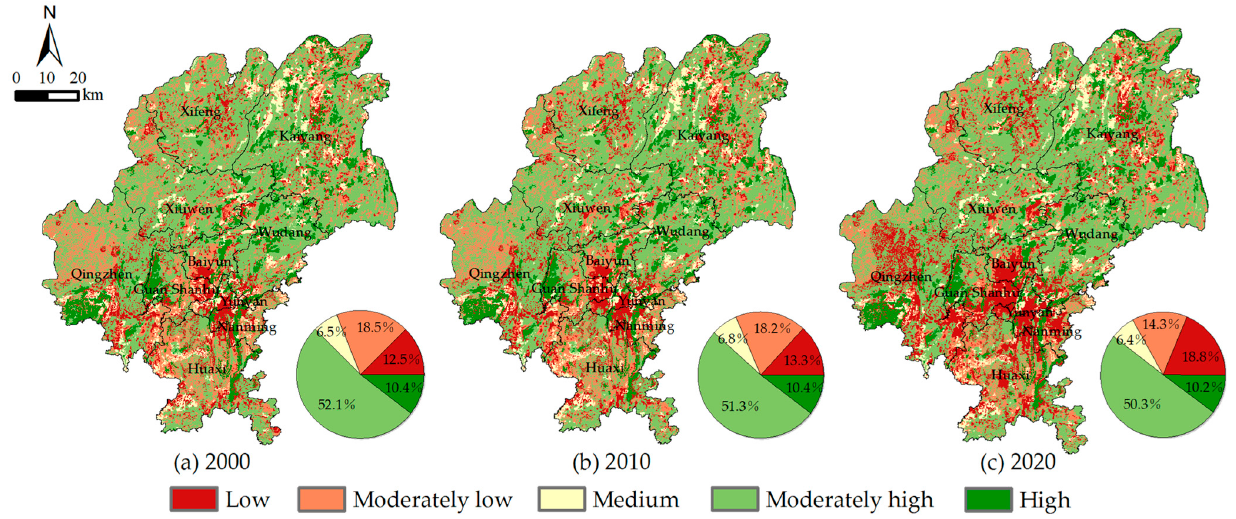
Figure 4. Spatio-temporal patterns of habitat quality in Guiyang city from 2000 to Figure 4. Spatio ‐ temporal distribution of habitat quality in Guiyang city from 2000 to 2020.